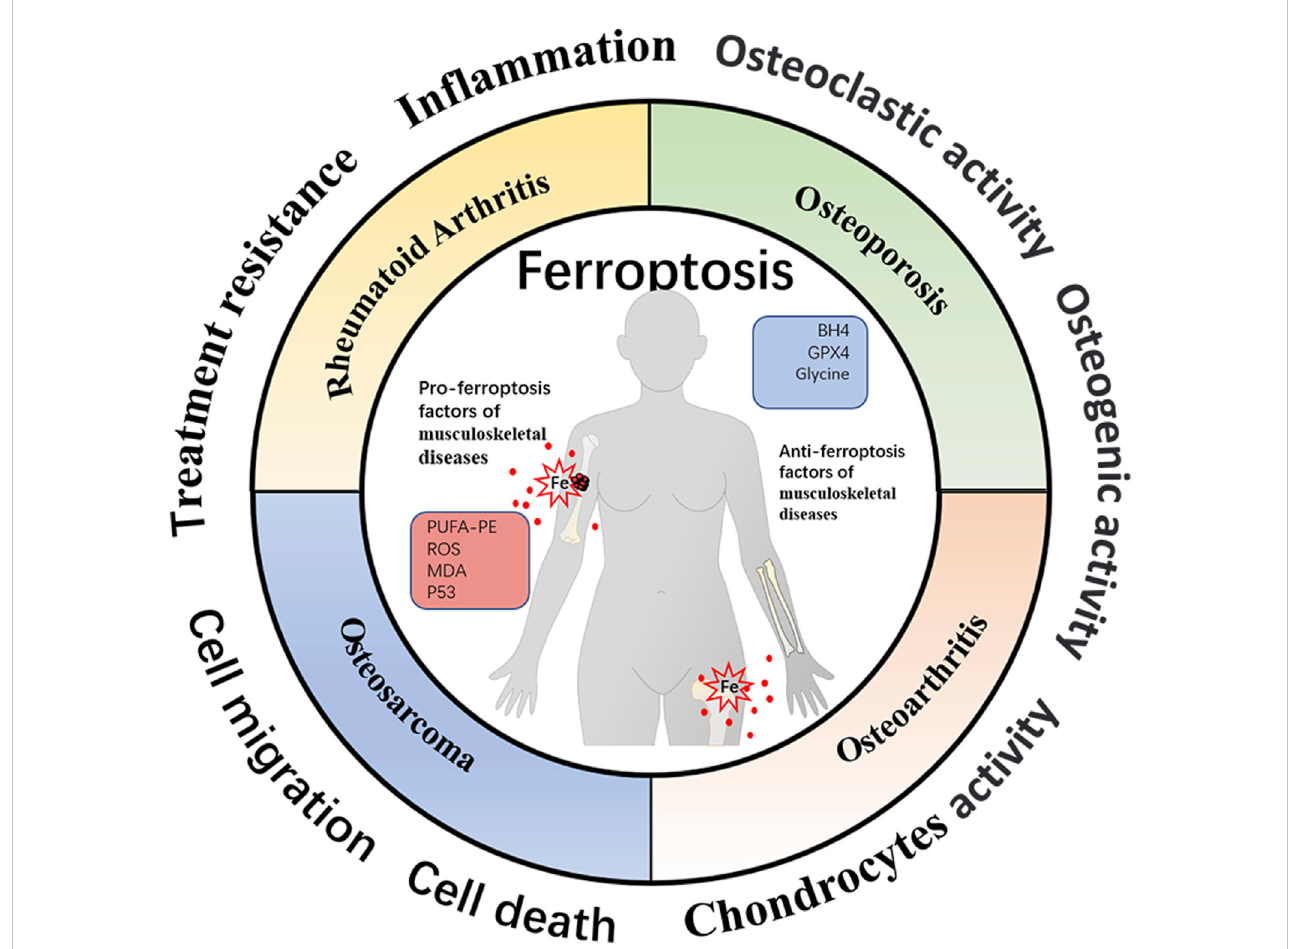
FIGURE 3 Schematic representation of ferroptosis-associated biomarkers in four different musculoskeletal diseases. The pro fi les of ferroptosis-related molecules have been proven to be well-established mediators affecting musculoskeletal disease progression and therapeutic response. The organic hallmarks present the biological functions of musculoskeletal diseases, including in fl ammation, cell death, cell migration, treatment resistance, etc.